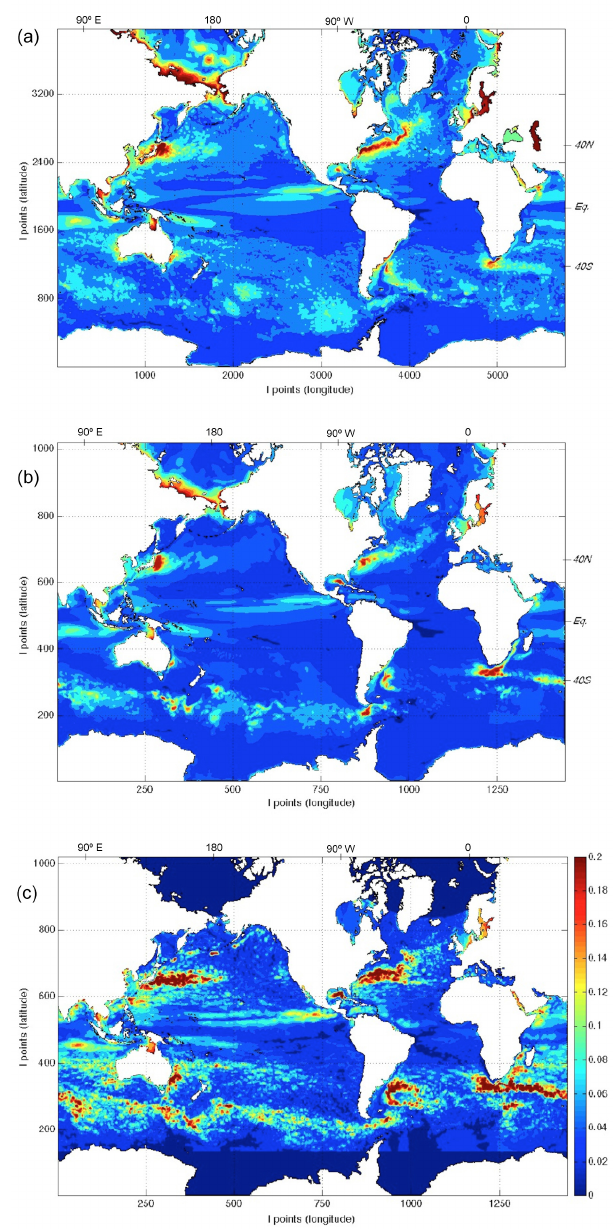
Figure 11. Sea surface height variability (in m) from (a) the GLOB16 model, (b) the GLOB4 model, and (c) AVISO. Modelled fields are shown on the own model grid; observations are interpo- lated on the eddy-permitting ORCA grid. Numbers of grid points are indicated on the axis, along with indications of latitudes and